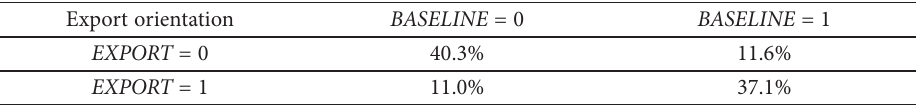
Table 7. Comparison of the model predicting business export orientation from structural variables to the actual export orientation of the firm Export orientation BASELINE =